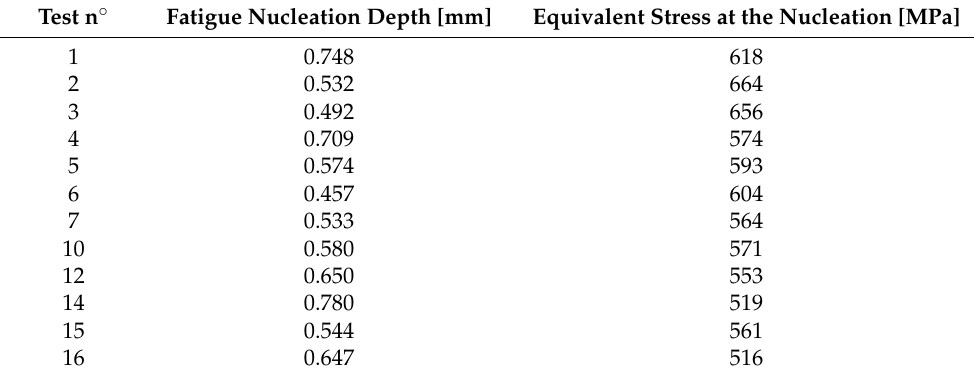
Table 10. Fatigue nucleation depth and equivalent stress evaluated at the nucleating